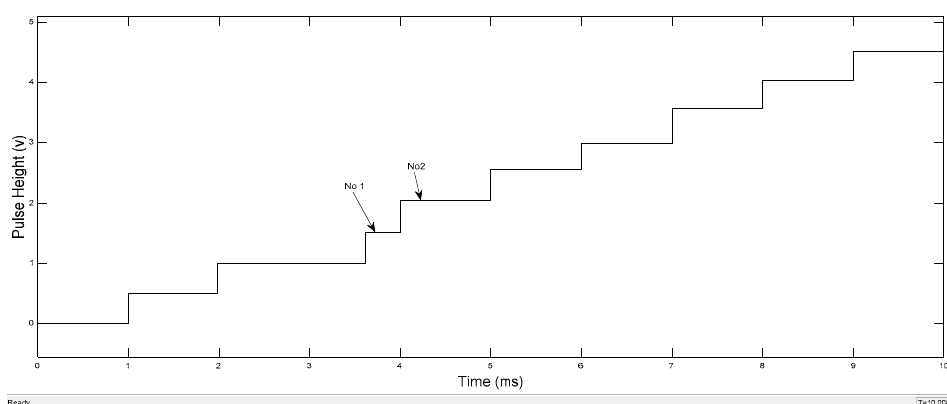
Figure 7. Non-pile-up using the TPS algorithm.